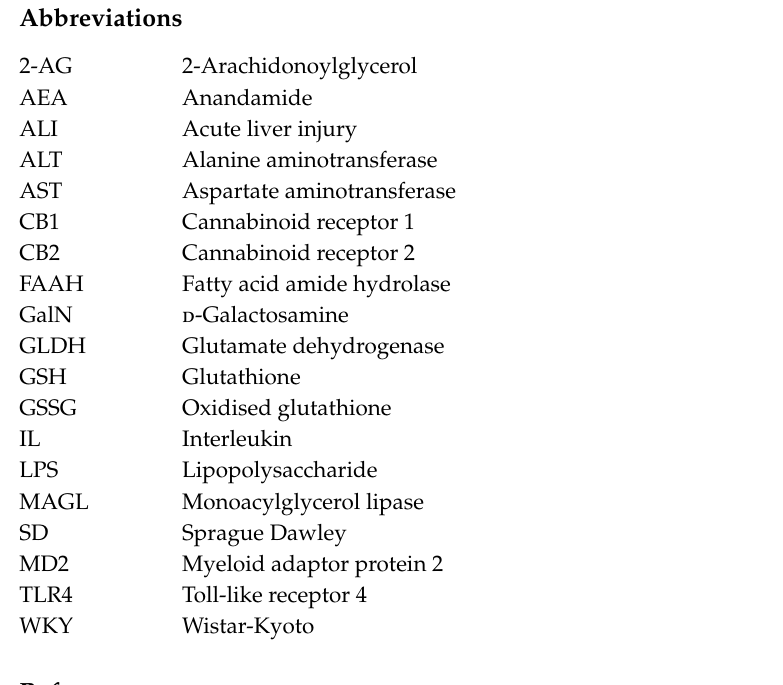
Figure S3: Representative full western immunoblot image of β -actin and